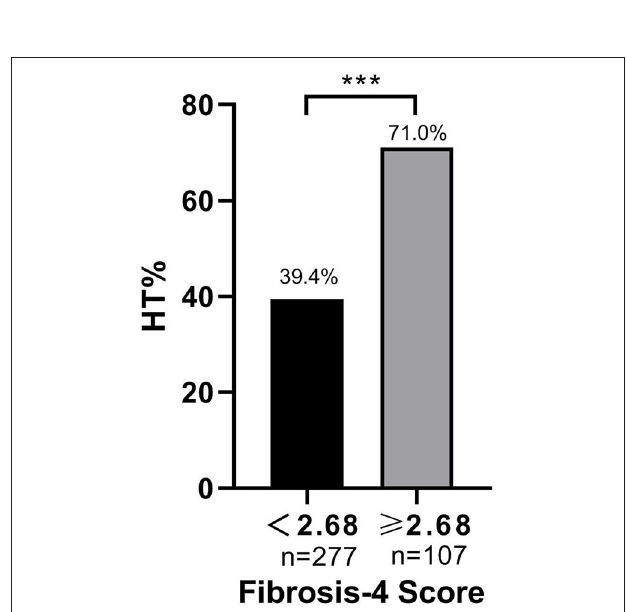
FIGURE 3 | The incidence of HT at different FIB-4 score. *** P < 0.001.